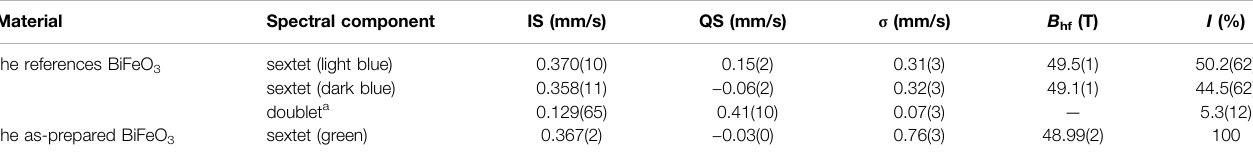
TABLE 2 | Parameters obtained by fi tting the room-temperature 57 Fe Mössbauer spectra of BiFeO 3 samples synthesized by two various routes. IS is the isomer shift; QS is the quadrupole splitting; σ is the Gaussian width of the spectral component; B hf is the magnetic hyper fi ne fi eld; I is the relative intensity of the spectral component. Material Spectral component